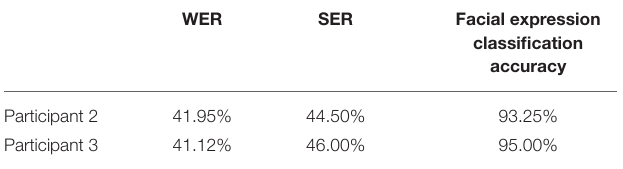
TABLE 5 | User-independent validation